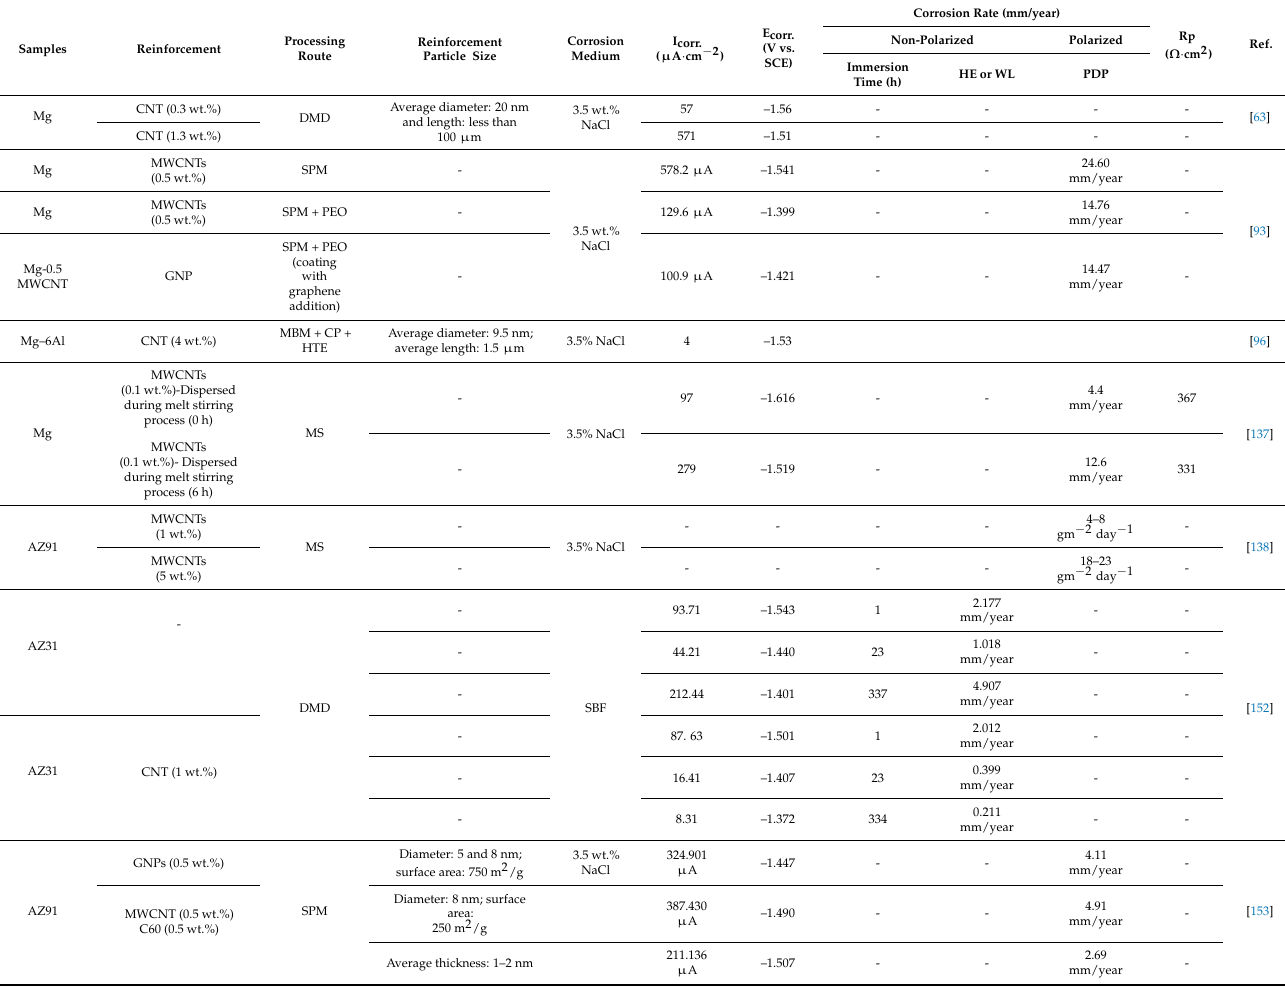
Table 2. Examined corrosion characteristics of fabricated CNT-reinforced magnesium